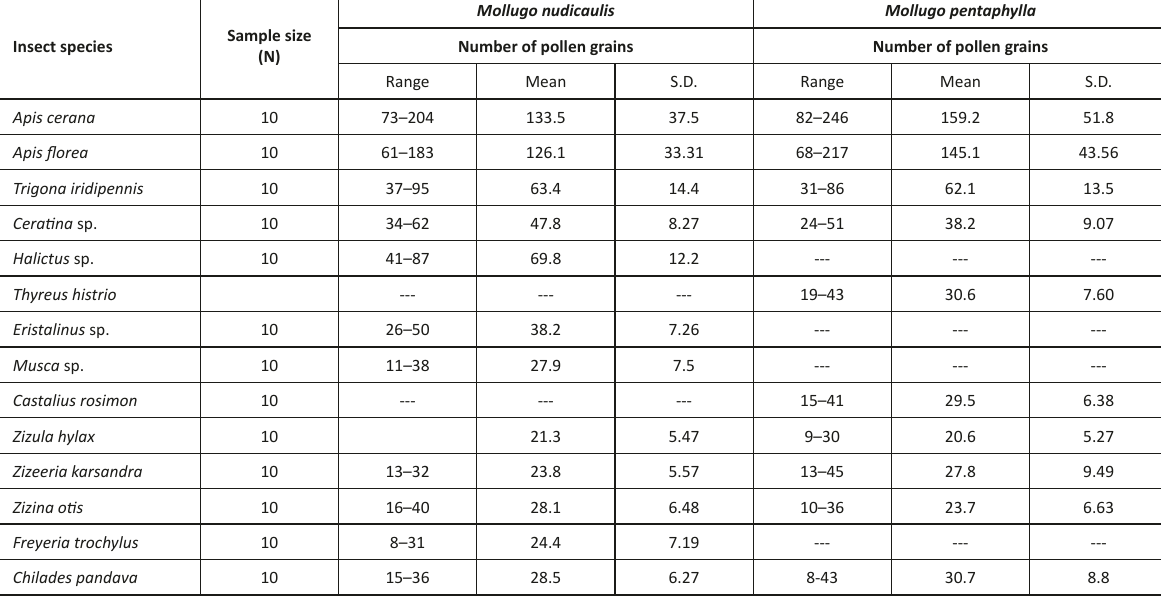
Table 3. Pollen recorded in the body washings of insects on Mollugo nudicaulis and Mollugo pentaphylla